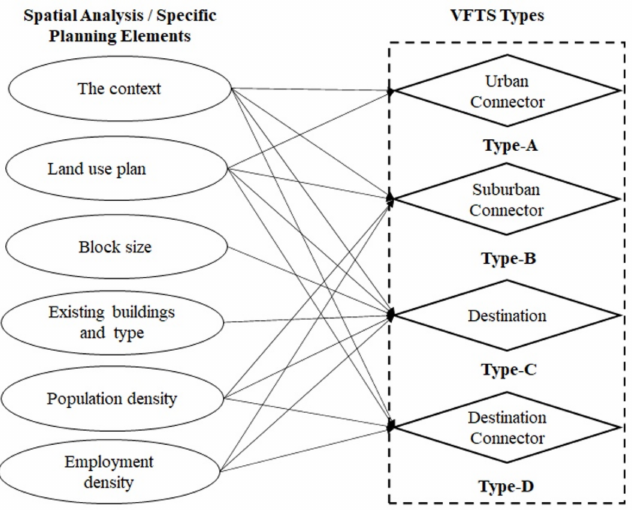
Figure 4. The spatial analysis-specific planning elements versus the VFTS